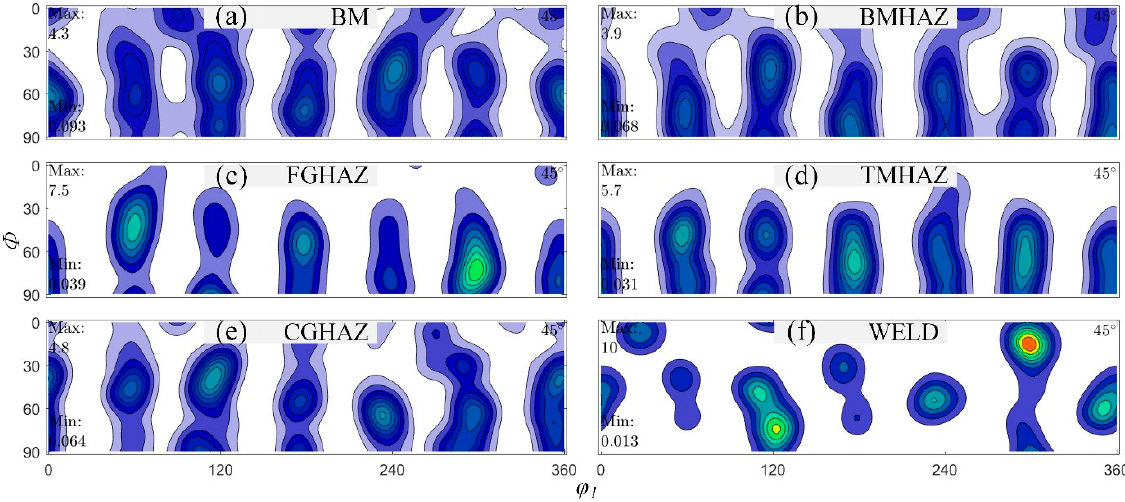
Figure 9. Orientation distribution function (ODF) cross section at ϕ 2 = 45 ◦ of the X100 laser-welded joint from the BM to the WELD.